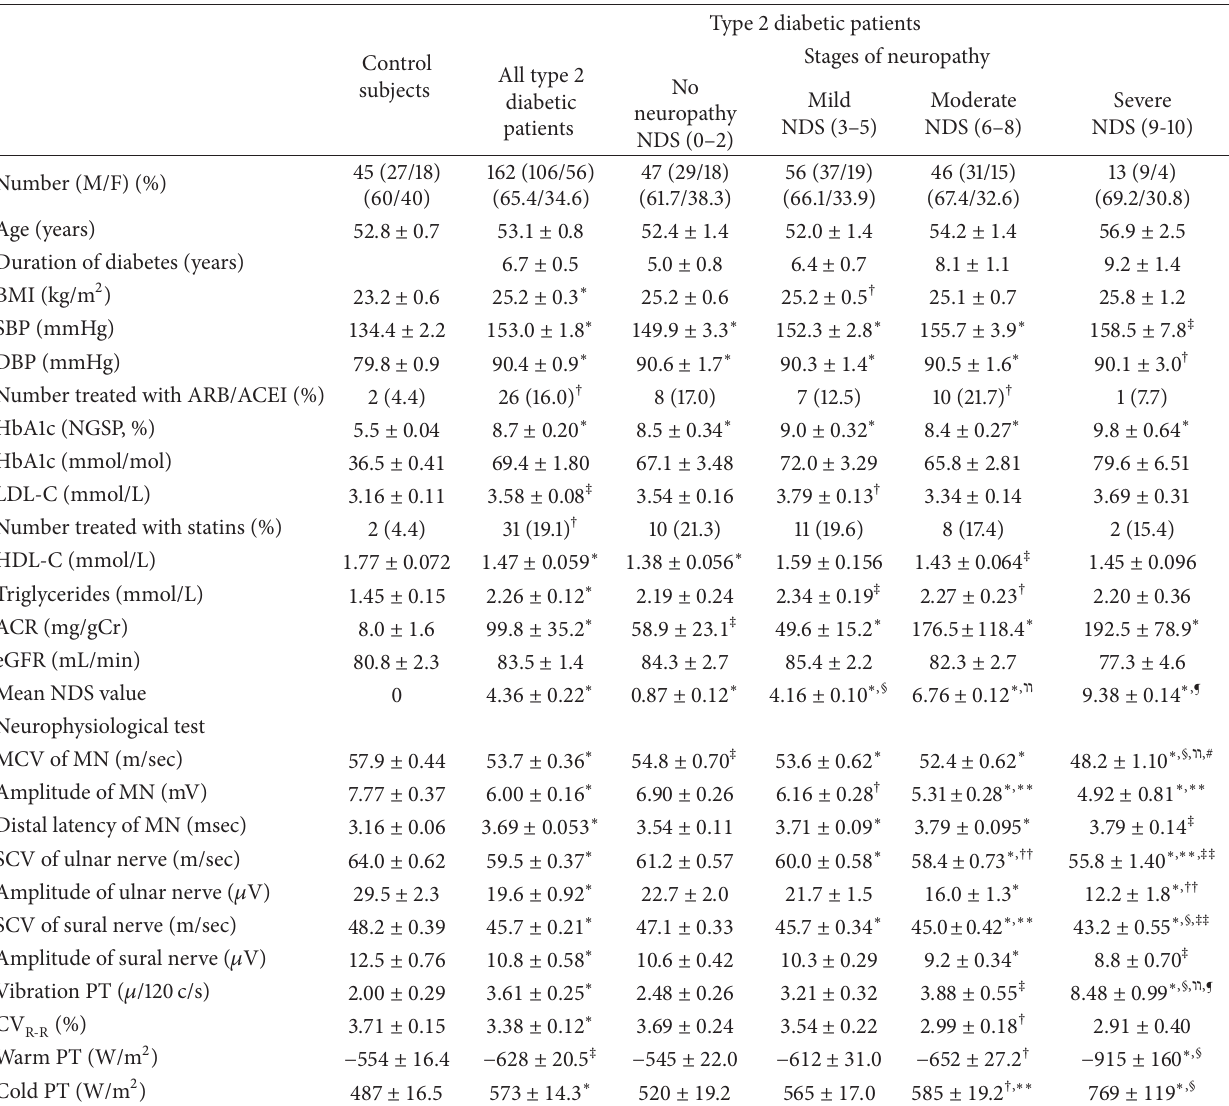
Table 1: Clinical characteristics and neurophysiological test of the control subjects, type 2 diabetic patients, and their subgroups stratified by the stages of